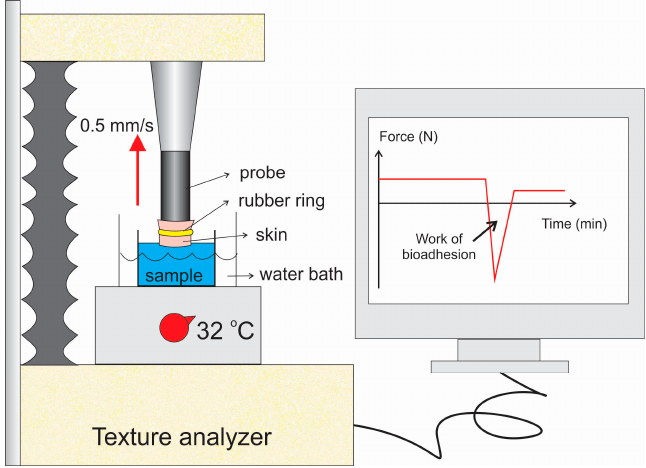
Figure 1. Scheme showing how the skin was adapted for the textural analyzer for the bioadhesion study. Table 1. Composition of the liquid crystal formulations (%, w / w ).